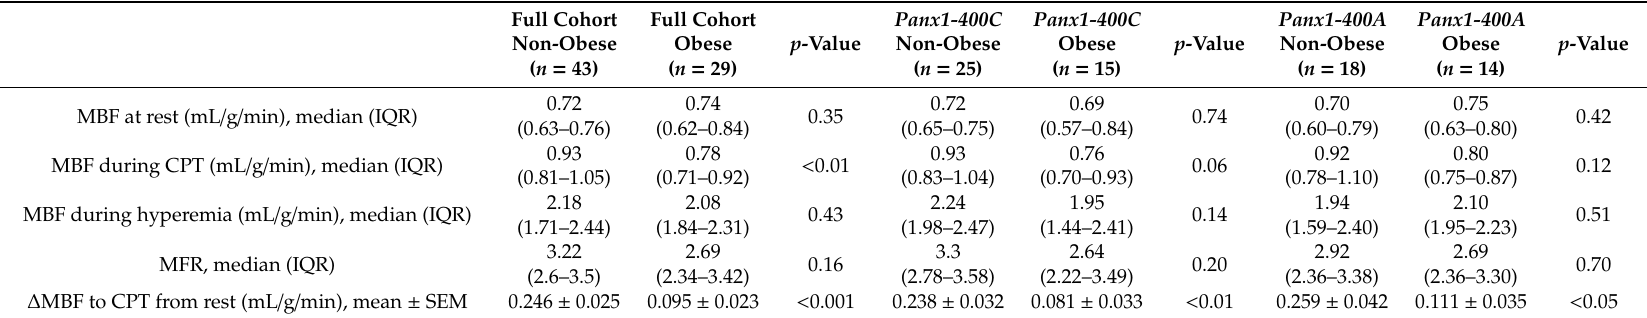
Table 3. MBF, MFR, and endothelial function measured during 13 N-ammonia PET / CT in non-obese and obese subjects from the three